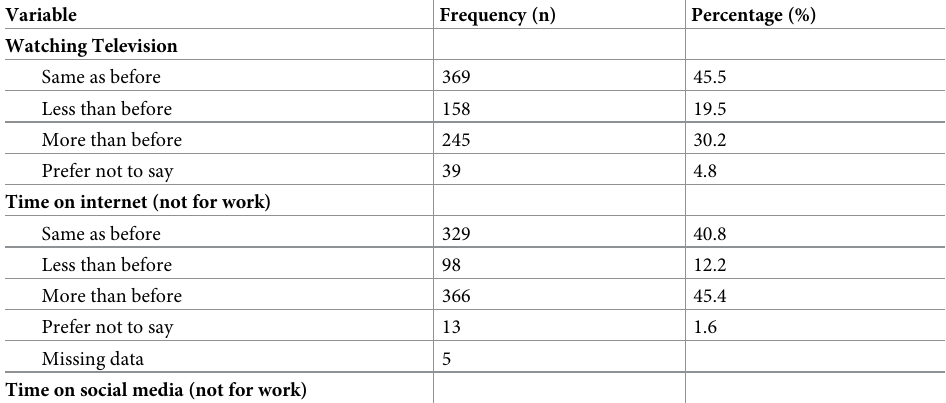
Table 3. Levels of engagement in various activities ‘during’ compared with ‘before’ the COVID-19 pandemic by participants (N =